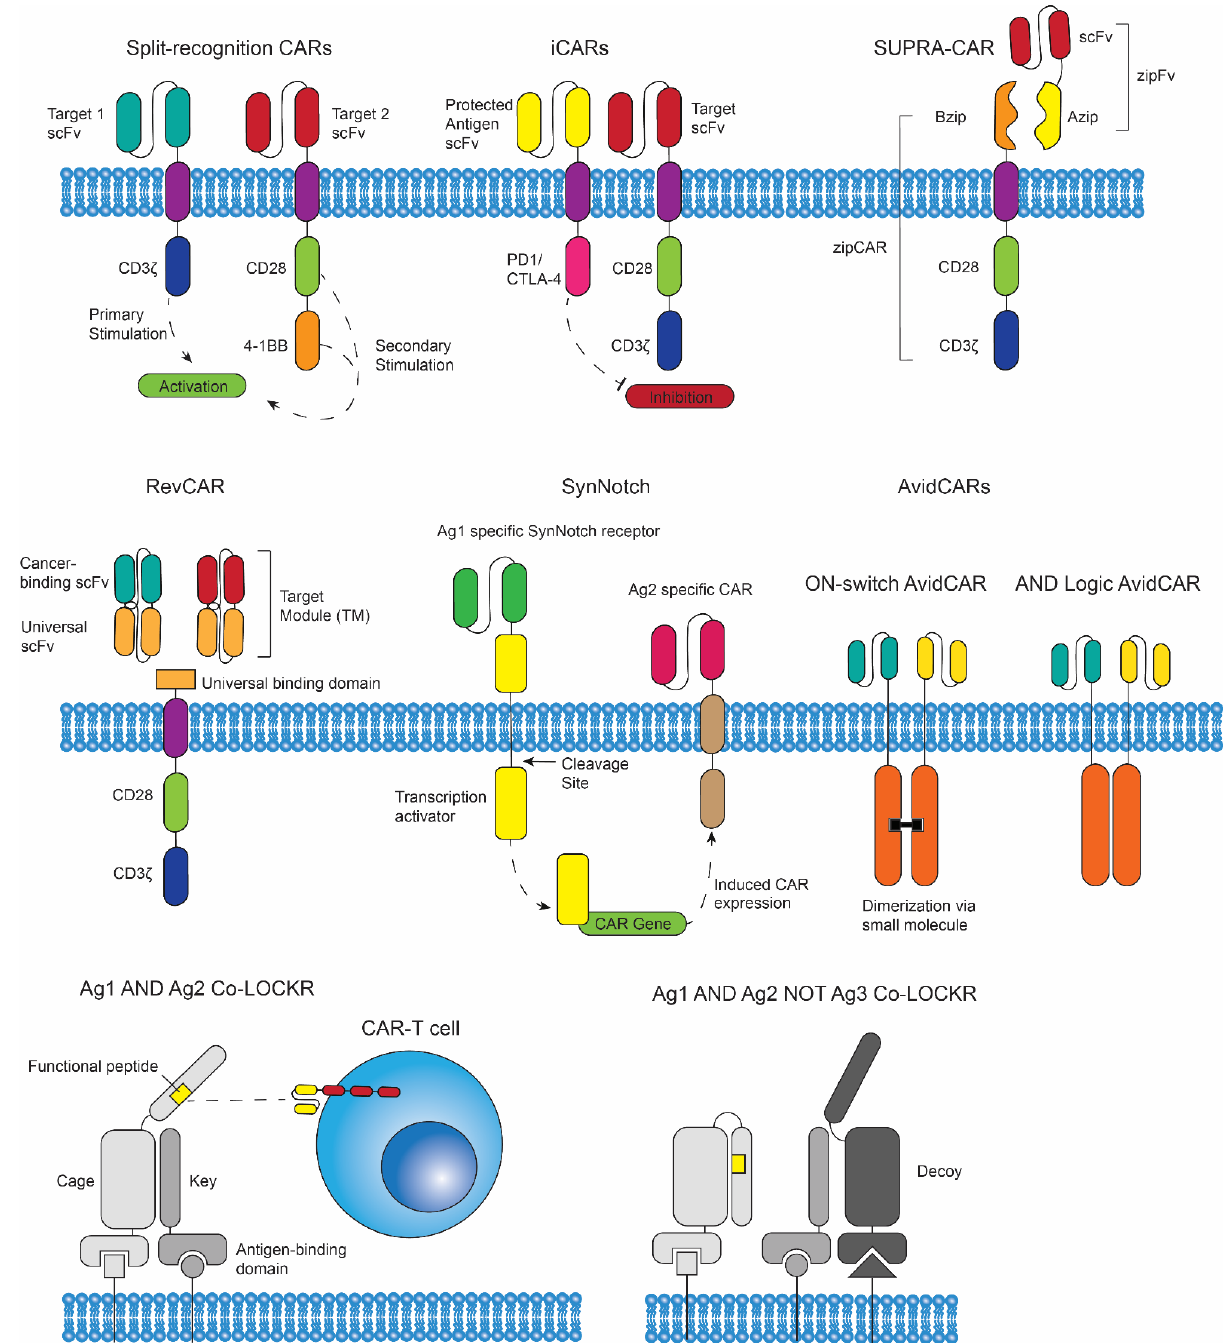
Figure 3. Various applications of logic gated CAR constructs. Split-recognition CARs separate the primary (CD3 ζ ) activation domains from the co-stimulatory domains (CD28/4-1BB), with each having separate scFv binding regions. Activation of both scFvs will produce a combined activation signal to the T cell. Inhibitory CARs (iCARs) use a separate inhibitory construct to prevent activation of the CAR T cell when the protected antigen scFv is bound. The inhibitory activation domain uses the signaling domains of inhibitory coreceptors (PD-1/CTLA-4) to produce an inhibitory signal when bound to the protected antigen and prevents CAR T cell activation, even when the target scFv is bound. SUPRA CARs have a zipCAR, which is composed of classic transmembrane and activation domains bound to a basic leucine zipper (Bzip). The zipFv, composed of a Azip region and the scFv,